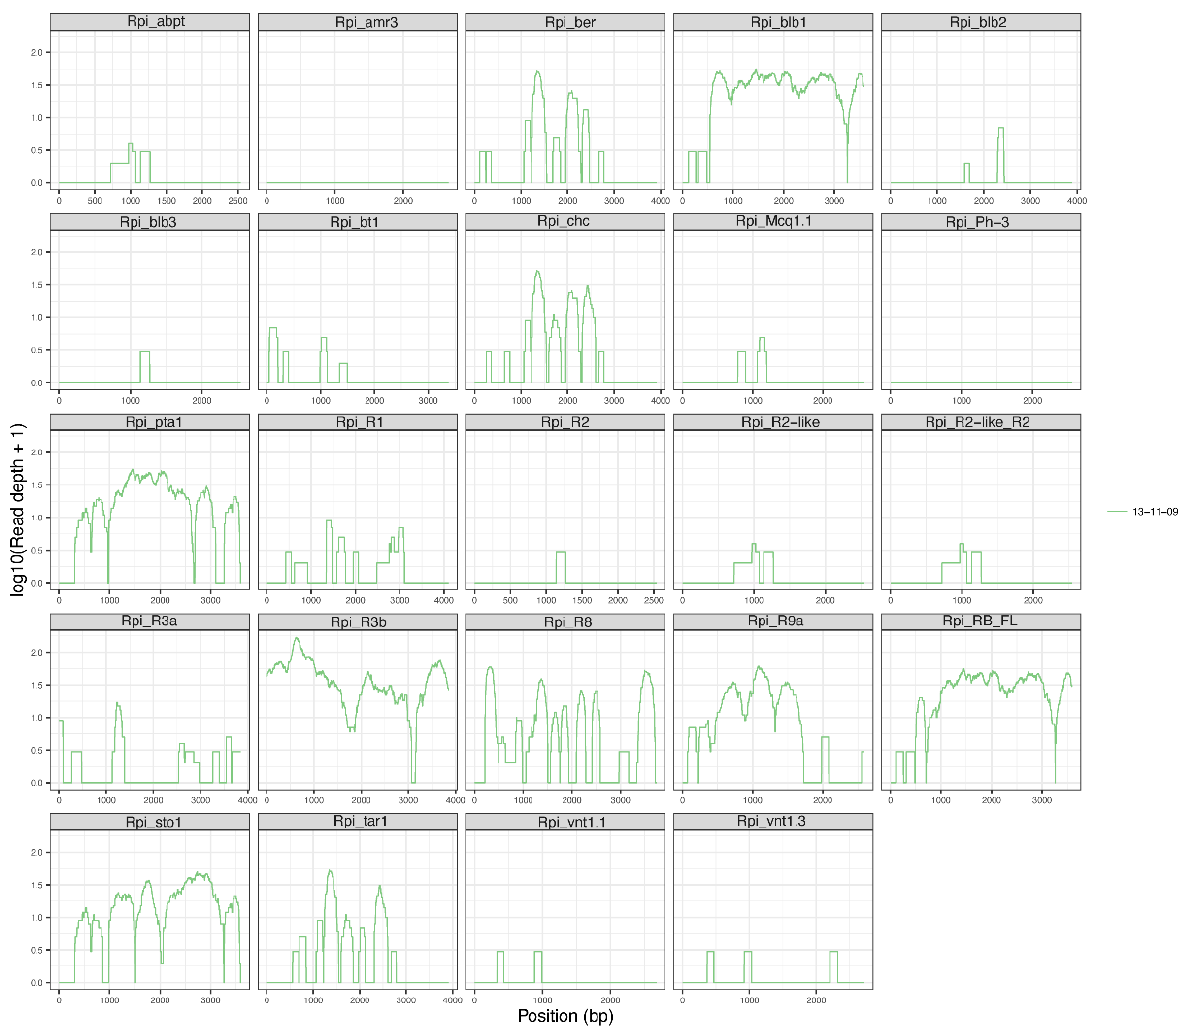
Figure 5. dRenSeq analysis in 13/11-09 clone. The sequence representations of known NLRs effective against late blight are shown in each box.